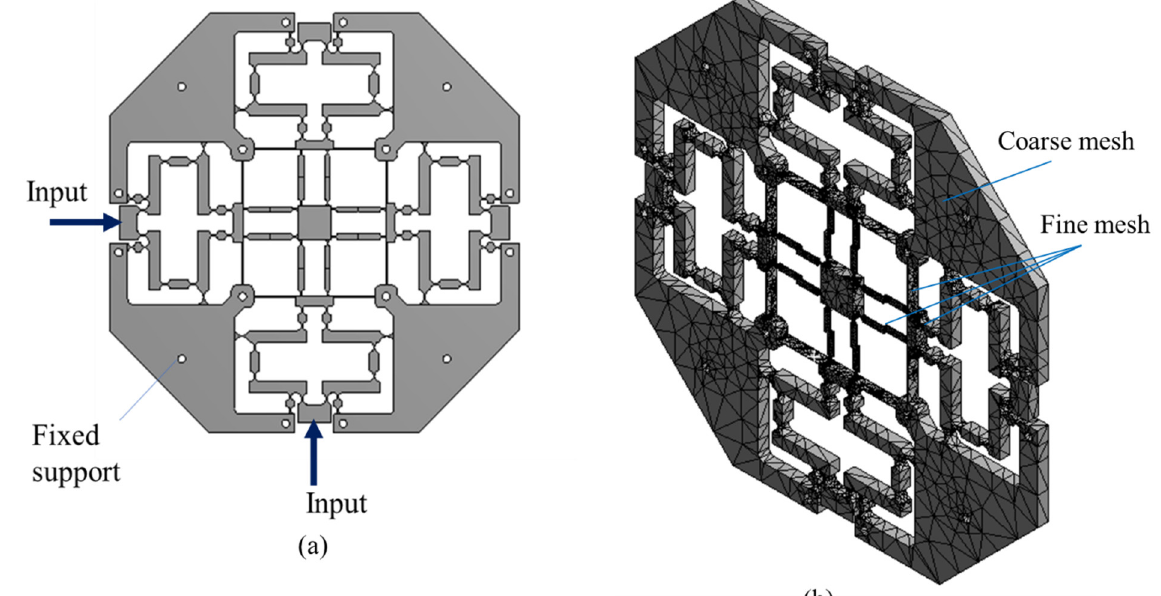
Figure 6. Boundary condition of XYZ micropositioner simulation: ( a ) Boundary condition, ( b ) mesh.